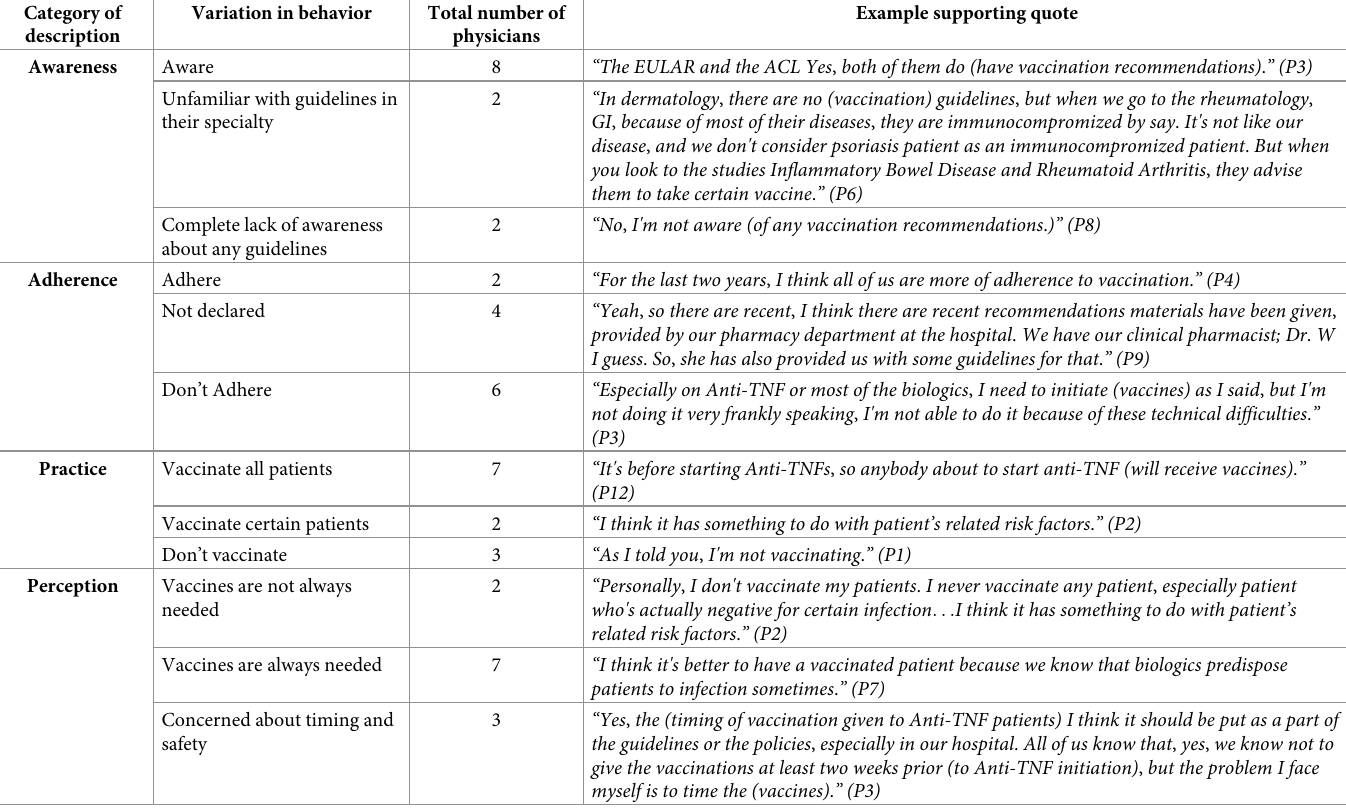
Table 4. Findings of the phenomenographic analysis with regards to variation in physicians’ views and perceptions about vaccination for patients receiving Anti- TNF. Category of description